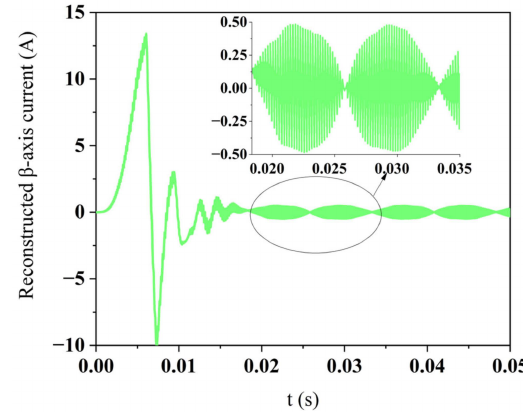
Figure 2. Reconstructed β -axis